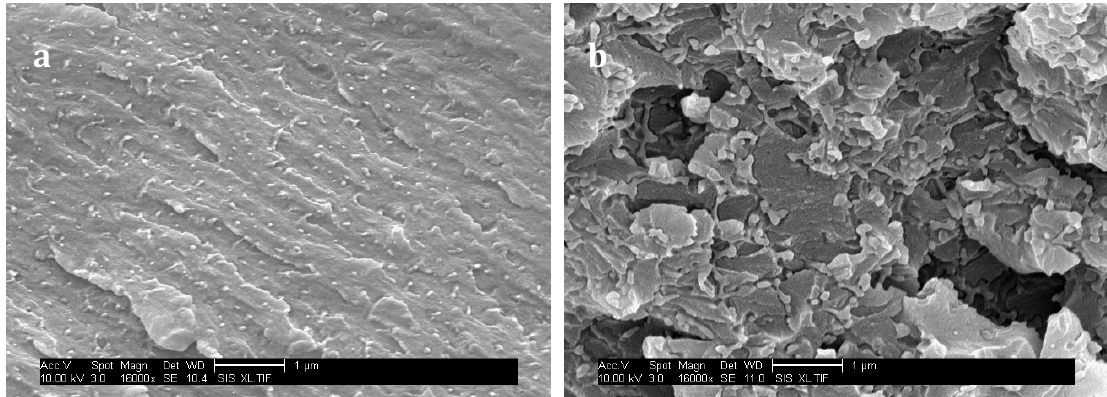
Figure 11. SEM observations of surface fracture for the f-PES ( a ) and nf-PES ( b ) modified networks cured at 150 °C without any chemical treatment.